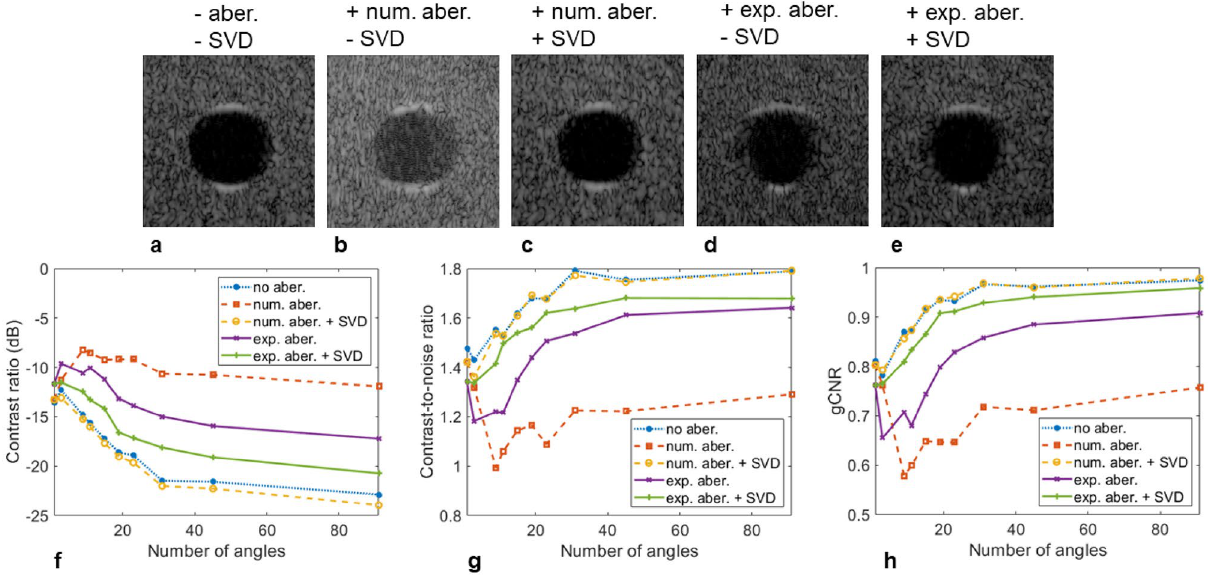
Figure 6. Quantification of contrast on the hypoechoic cyst located at 80 mm (see Fig. 5) as a function of the number of plane waves when aberrations are introduced. ( a – e ) Expanded view of the cyst without aberration ( a ), after introducing a numerical aberration before ( b ) and after ( c ) applying the SVD beamformer, after introducing an experimental aberrating layer before ( d ) and after ( e ) applying the SVD beamformer. The dynamic range is 60 dB for all images. ( f – h ). The contrast ratio ( f ), contrast-to-noise ratio ( g ) and generalized contrast-to-noise ratio ( h ) as a function of the number of angles shows a clear degradation in the presence of aberration.